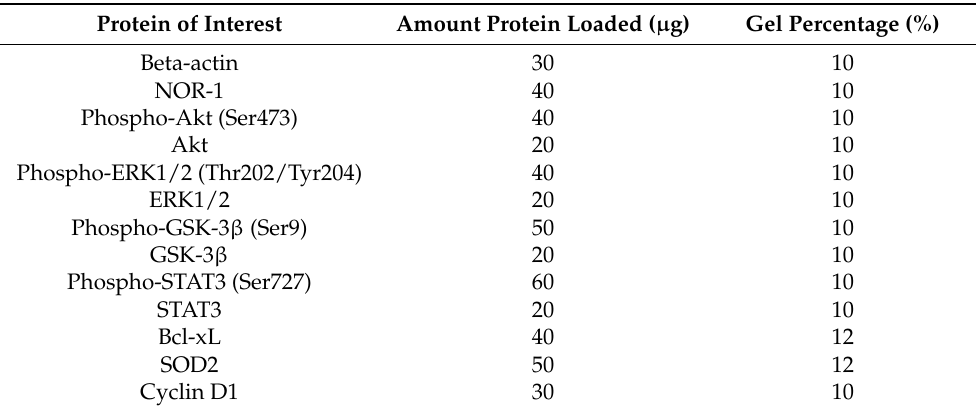
Table 1. Amount of protein loaded, and gel percentage used during Western